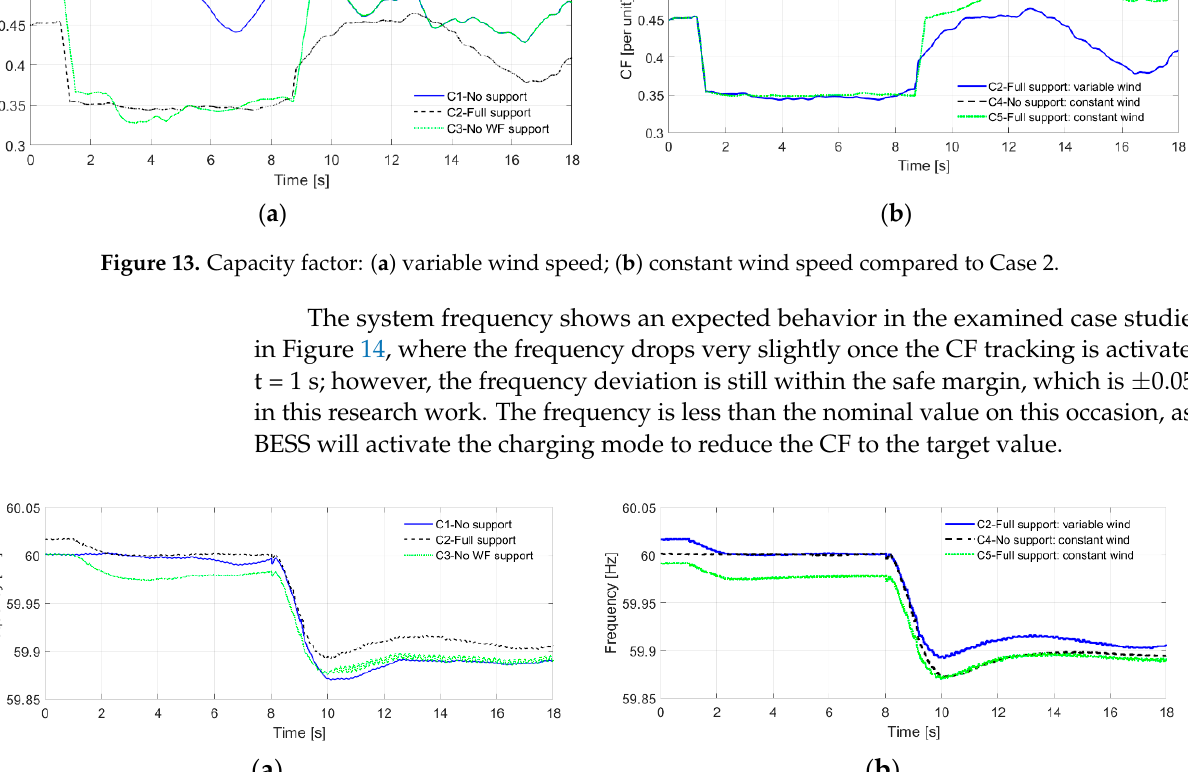
Figure 13. Capacity factor: ( a ) variable wind speed; ( b ) constant wind speed compared to Case 2.